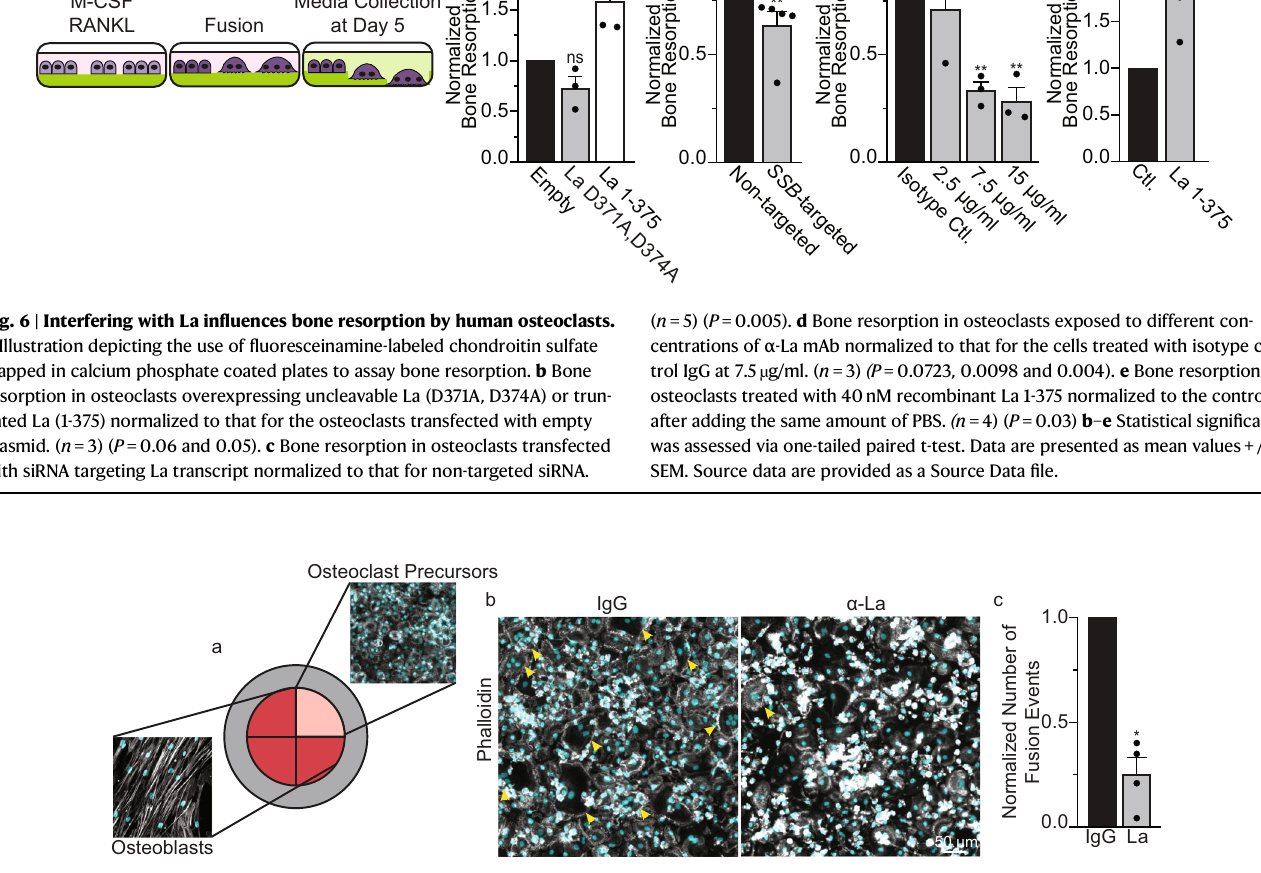
osteoclast fusion in the presence of 6 μ g/ml control IgG or α -La mAb antibodies. Arrowheadsdenote syncytiawith ≥ 3nuclei. c Quanti fi cationofosteoclastfusionin the co-cultures in the presence of α -La mAb normalized to that in the presence of control IgG. ( n =4) ( P =0.03) Statistical signi fi cance was assessed via one-tailed paired t-test.Dataare presentedasmeanvalues+/-SEM.Source dataare provided as a Source Data fi